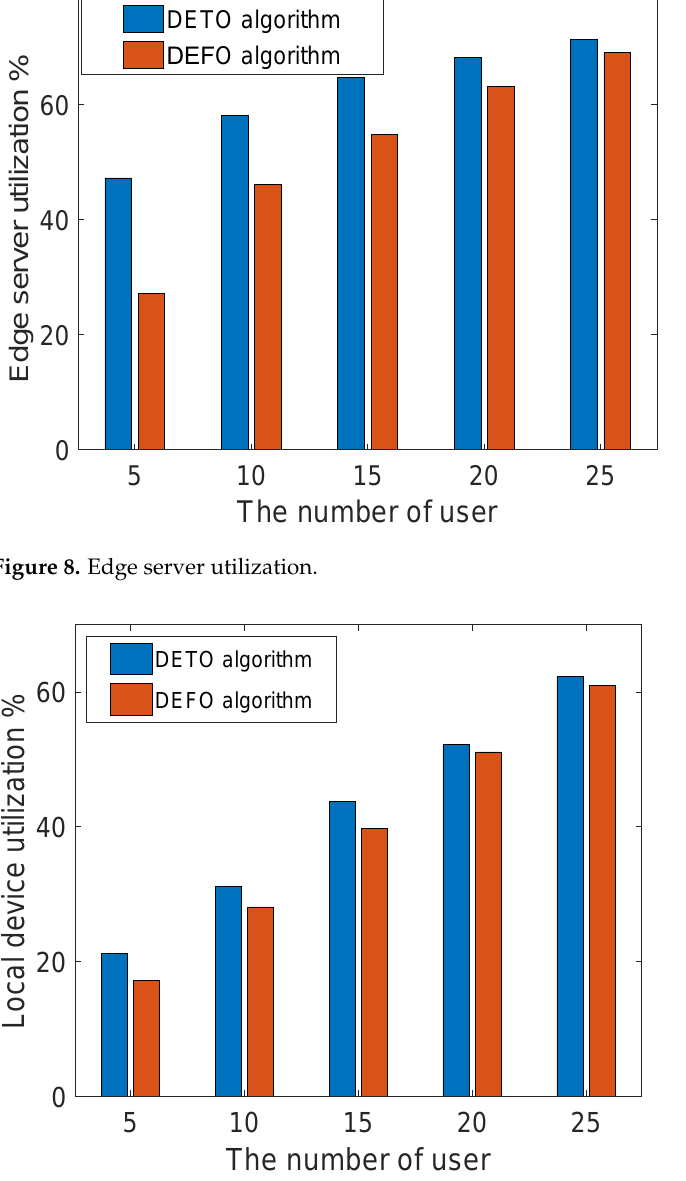
Figure 9. Local device